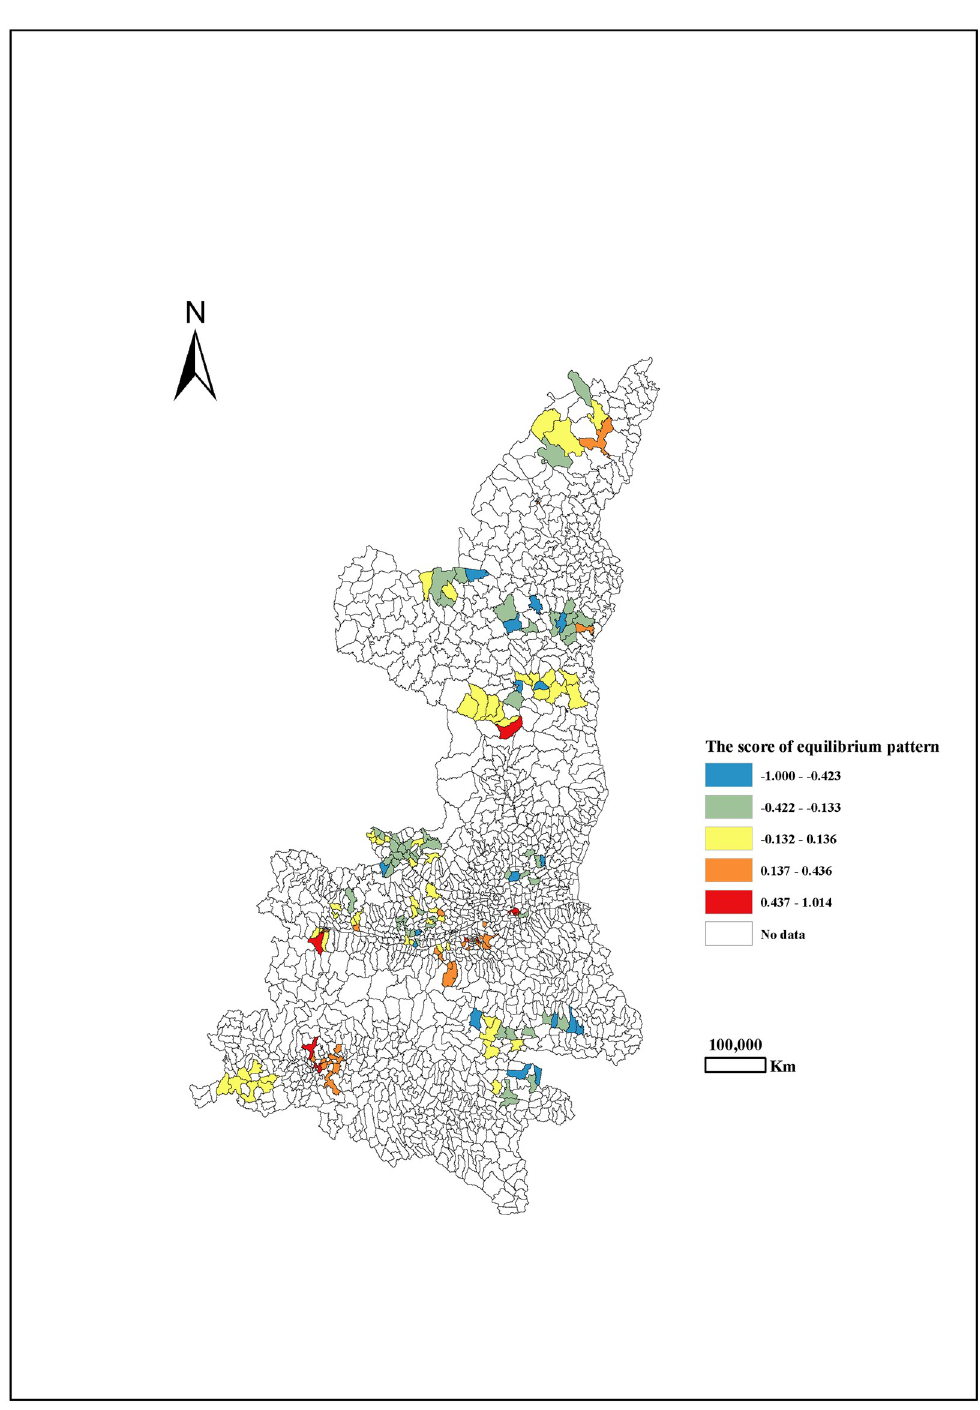
Fig 1. The score of equilibrium pattern among pregnant women by different areas in Shaanxi province, 2013.